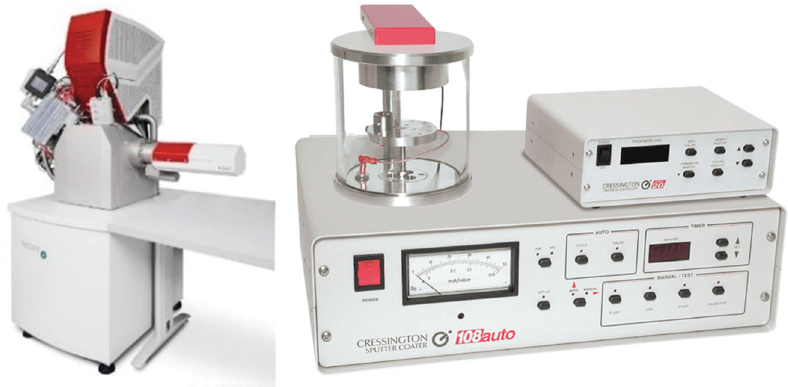
Figure 2: Focused ion beam scanning electron microscope and gold sprayer.